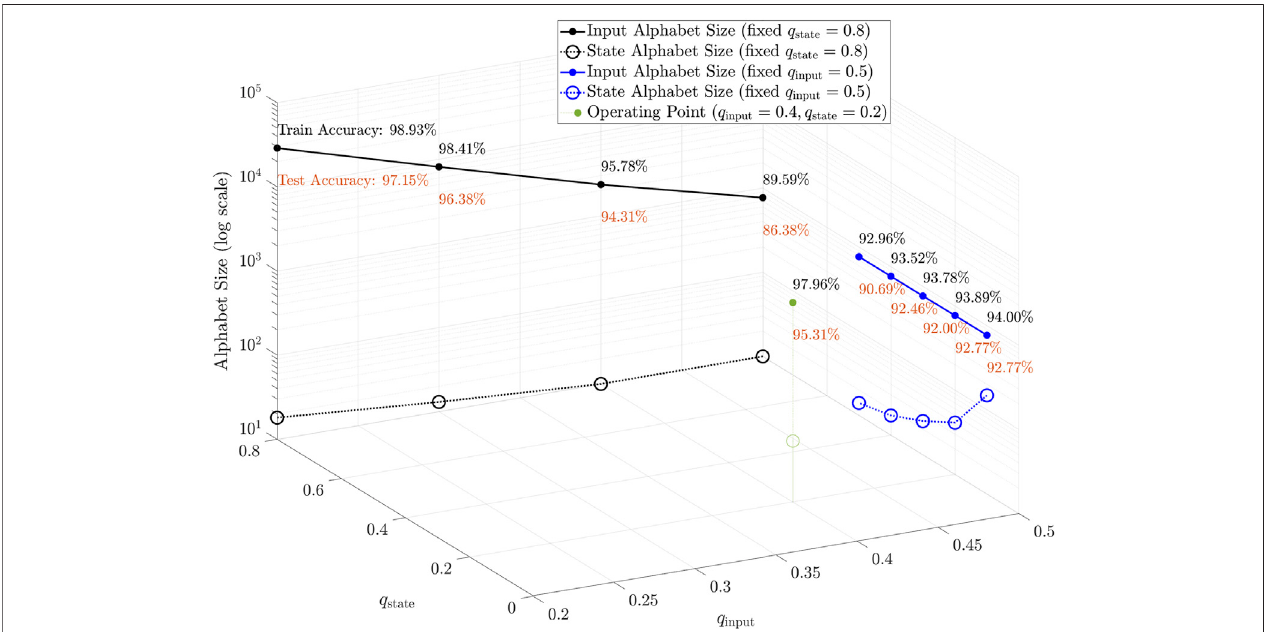
FIGURE 4 | Performance as a function of quantization thresholds. Input alphabet is uniquely determined by its quantization factor q input (e.g., the solid blue line showsaconstantalphabetsizeof770fora fi xedthreshold q input (cid:1) 0.5,regardlessofstatequantizationvalues), whereasthestatealphabetisafunctionofboththeinput andstatequantizations(e.g.,dashed blacklineshowsareducedstatealphabetastheinputquantizationincreases,evenwiththestatequantization fi xedat q state (cid:1) 0.8). Certain states become unreachable when the data resolution is reduced. Clearly, latent states are parsimonious descriptors of nonlinear dynamics: good recognition accuracies are maintained using only a small subset of the original state space points, i.e., most state variables orbit a few attractors.